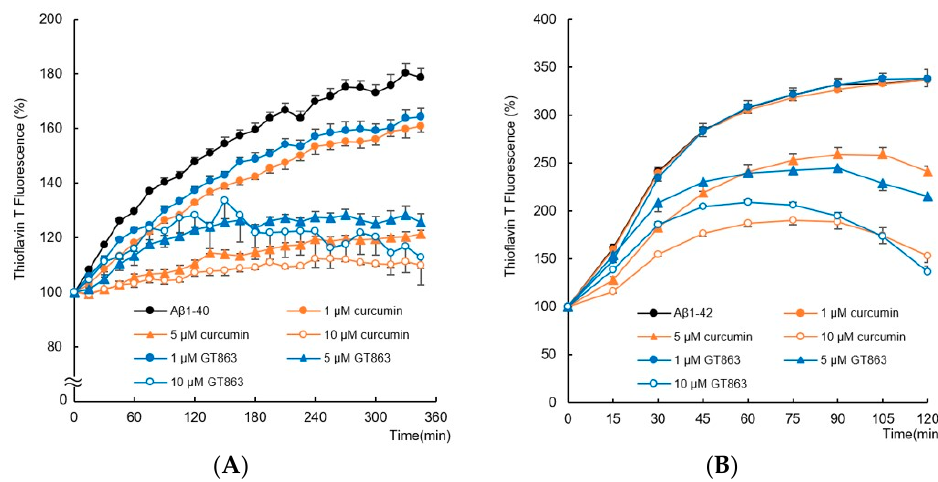
Figure 2. Inhibitory effect of GT863 and curcumin on A β 1 − 40 and A β 1 − 42 aggregation kinetics as monitored by the thioflavin − T fluorescence assay. The fluorescence intensity was evaluated with the value immediately before administration as 100%. ( A ) A β 1 − 40 (25 μ M) with 0.1% DMSO, curcumin (1, 5, 10 μ M), or GT863 (1, 5, 10 μ M). ( B ) A β 1 − 42 (25 μ M) with 0.1% DMSO, curcumin (1, 5, 10 μ M), or GT863 (1,5,10 μ M). The p − values in ANOVA were < 0.001. Each value expresses the mean ± S.E.M. ( n = 6).